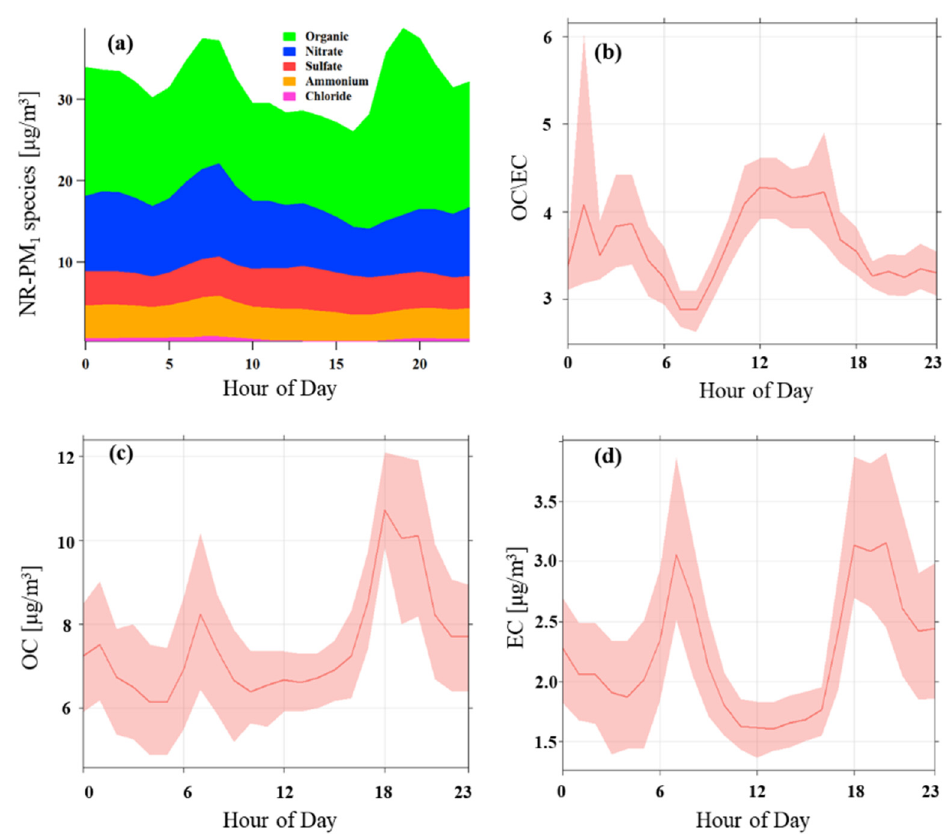
Figure 2. The diurnal variation of ( a ) non-refractory submicron particulate matter (NR-PM 1 ); ( b ) the ratio of OC to EC; ( c ) OC; ( d ) EC. The pink area represents the 95% confidence interval.